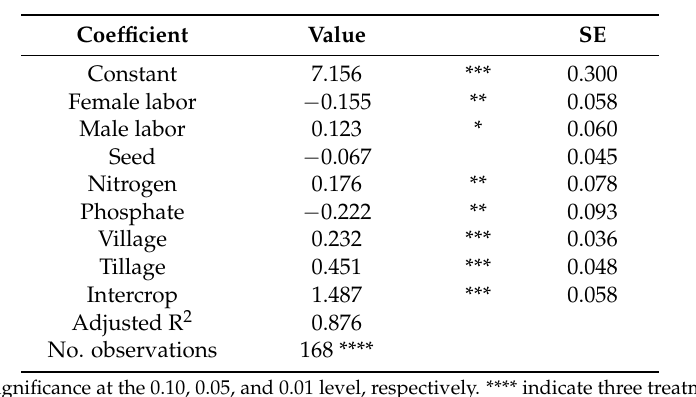
Table 3. Estimated regression coefficients of aggregate production function of maize equivalent yield (MEY) and various inputs by village by CA